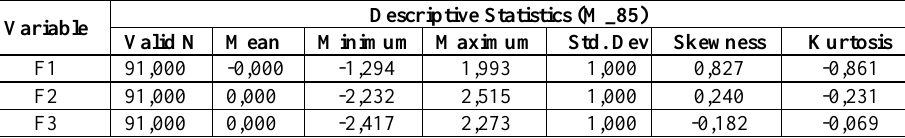
Table 2. Descriptive statistics of time series of the main components.